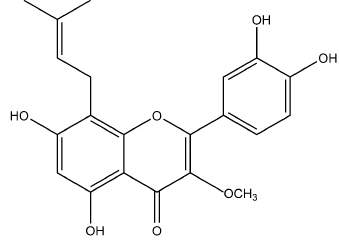
Figure 2. Flavonoid compound isolated from Sinopodophylli fructus .